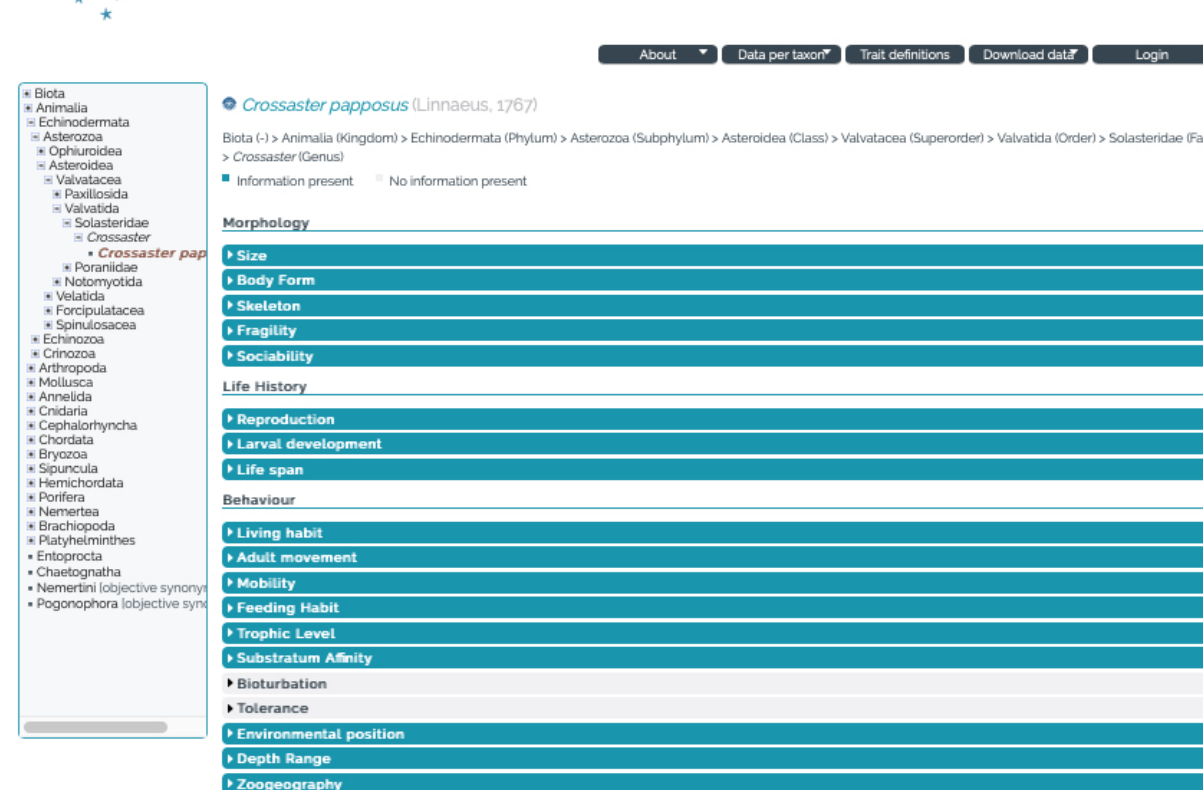
Figure 3. Screenshot of the taxon page of the asteroid Crossaster papposus selected from the classification tree on the left.